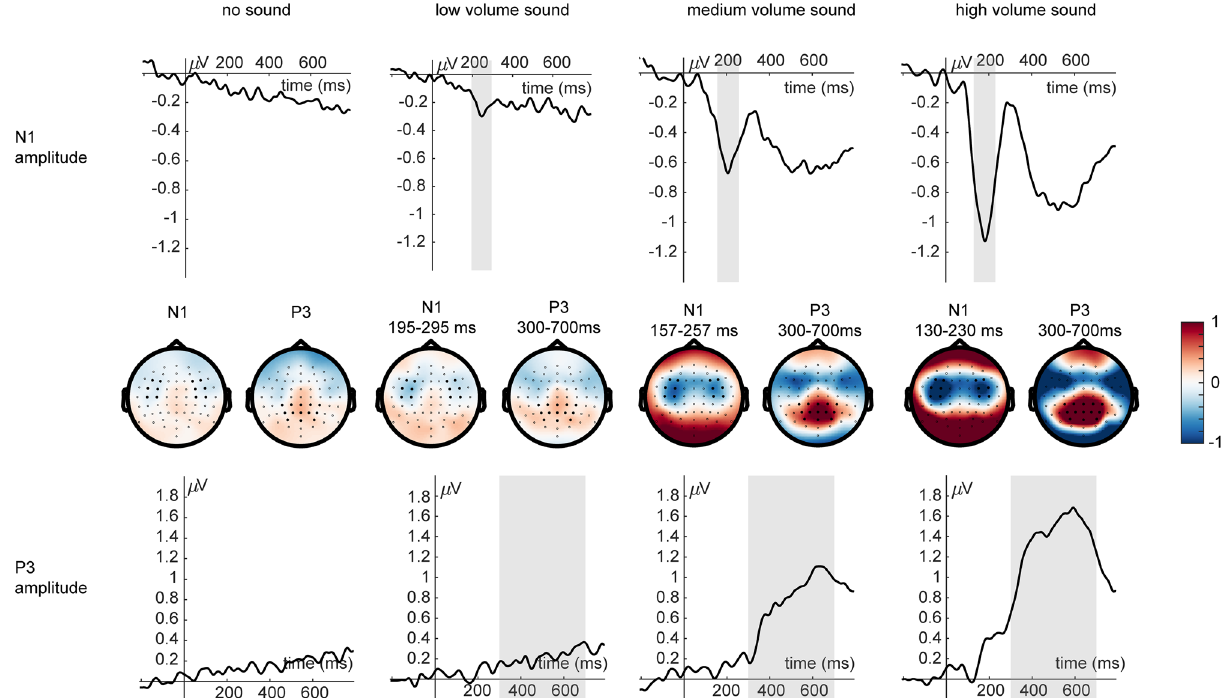
Figure 2. ERPs of the grand average ( n = 43) for the two load conditions and the four sound volume conditions in the N1 time range (top row) and in the P3 time range (bottom row) with topographies (middle